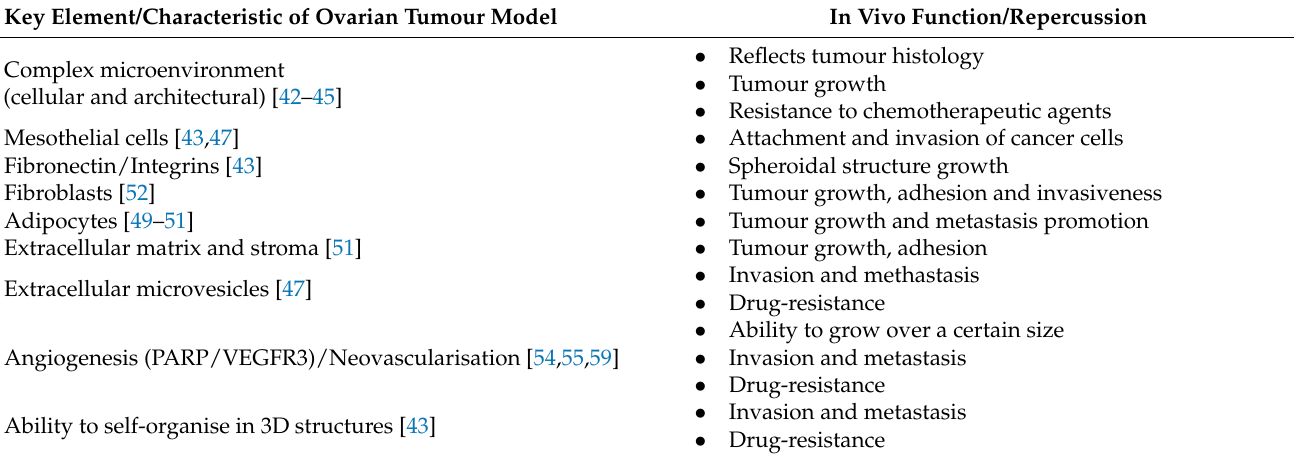
Table 1. Key characteristics of an ideal model of ovarian